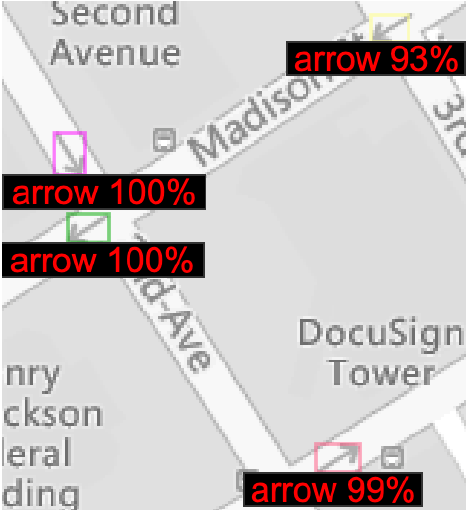
Figure 10. Second arrow position detection for Bing